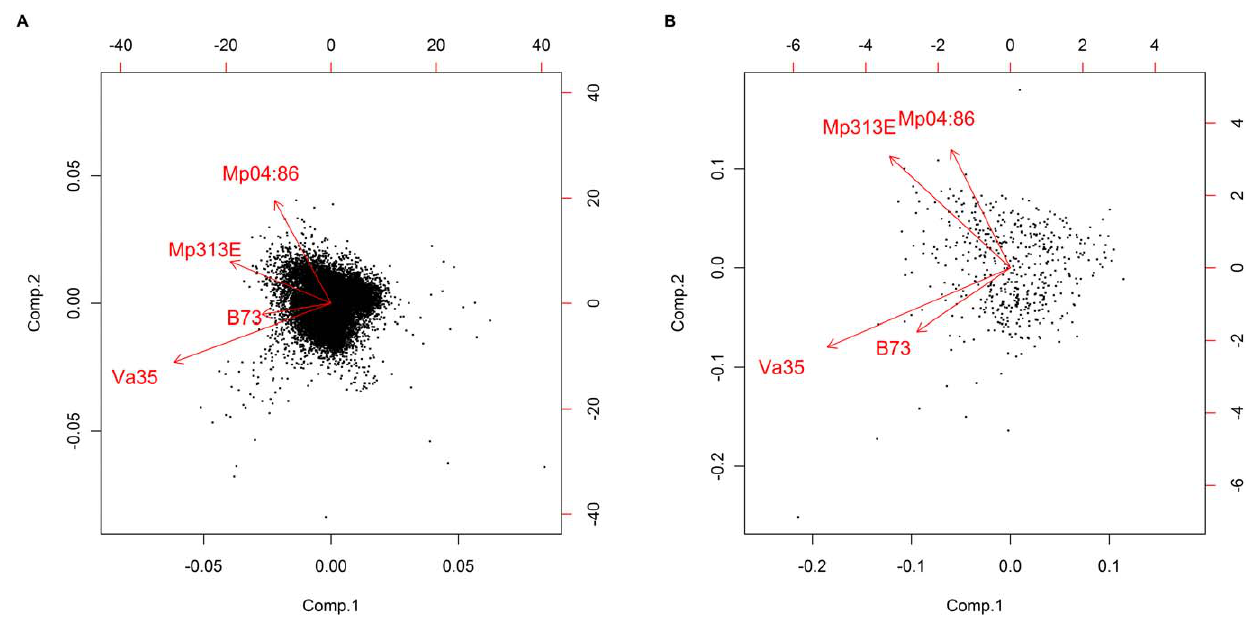
Figure 1. Biplots showing results of the principal component analysis (PCA) on log2 expression ratios (I/U) of 13,107 expressed genes. The distribution of the gene expression values shows evident trends represented by the vectors associated with resistant and susceptible maize inbred lines. Genes expressed toward the resistance trait were located close to the vectors for Mp313E and Mp04:86. Genes contributing to susceptibility were located close to the vectors for Va35 and B73. 1A. Biplot of principal component analysis (PCA) on 13,107 expressed gene probes. 1B. Biplot of principal component analysis (PCA) on a subset of 500 expressed gene probes. (The arrows represent vectors. The direction and length represent the larger variance of the expression